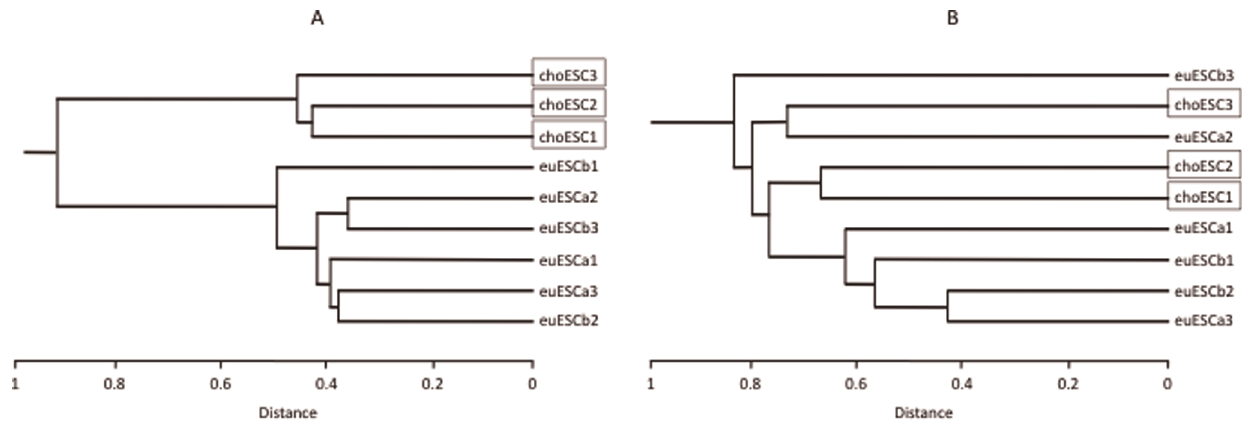
Figure 1. The results of the hierarchical clustering analysis of genome-wide DNA methylation status (A) and the transcriptome analysis (B). A hierarchical dendrogram showing that the choESC samples cluster according to lineage and were separated from the euESC samples